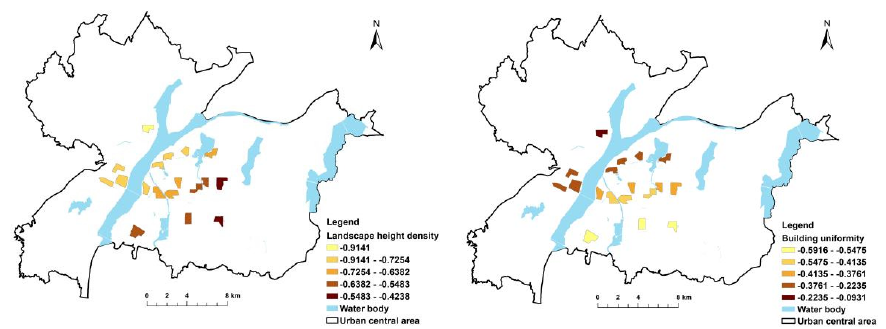
Figure 5. GWR results for residential function zone.